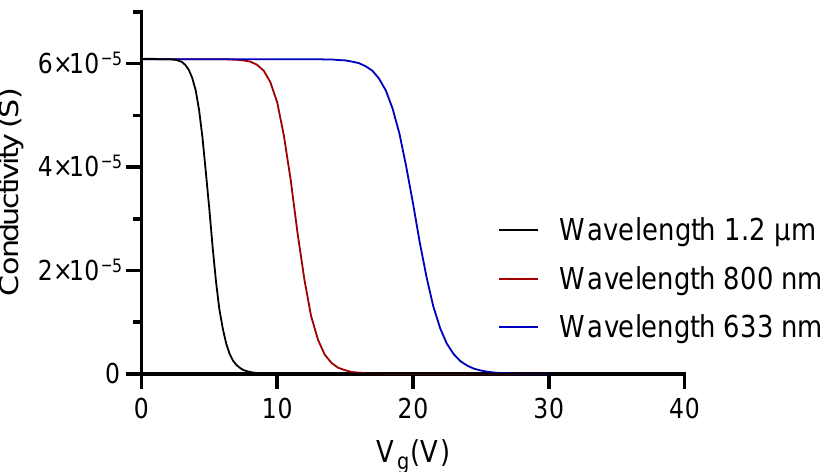
Figure 2. Graphene conductivity response as a function of V g applied voltage for 1.2 µ m, 800 nm and 633